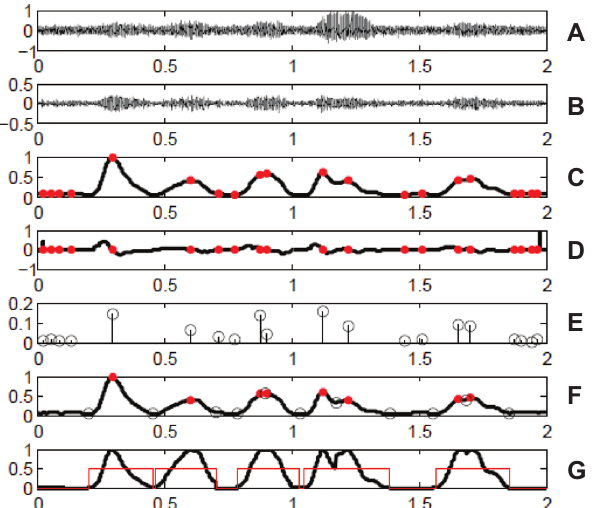
Figure 4. Enhancement of High-Energy Regions: (A) Noise-Added Speech, (B) CIMF, (C) Frame Energy, (D) First Order Difference, (E) Slope Values Computed at Each Peak Locations, (F) Loca- tion of Peaks and Valleys, and (G) Enhanced Energy